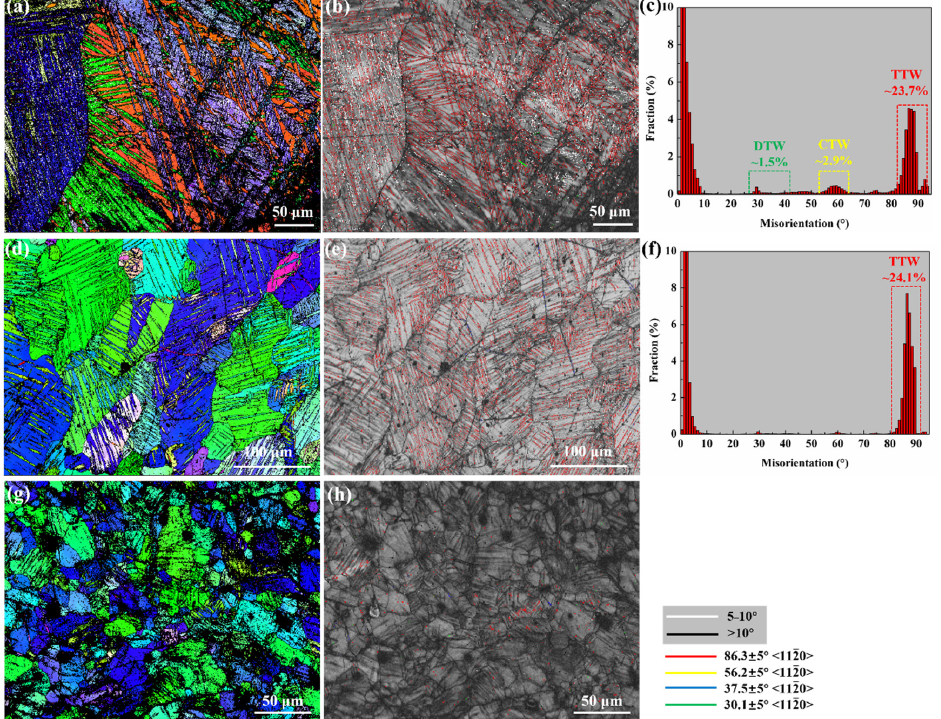
Figure 3. ( a ) EBSD IPF image of the HS-1 sample; ( b ) corresponding band contrast (BC) map of ( a ); ( c ) corresponding misorientation angle distribution map of ( b ). The {101 (cid:3364) 1}–{101 (cid:3364) 2} double twins, {101 (cid:3364) 1} contraction twins, and {101 (cid:3364) 2} tension twins are marked as DTW, CTW, and TTW, respectively; ( d ) EBSD IPF image of the E9S-1 sample; ( e ) corresponding BC map of ( d ); ( f ) corresponding misorientation angle distribution map of ( e ); ( g ) EBSD IPF image of the E25S-1 sample; ( h ) corresponding BC map of ( g ).